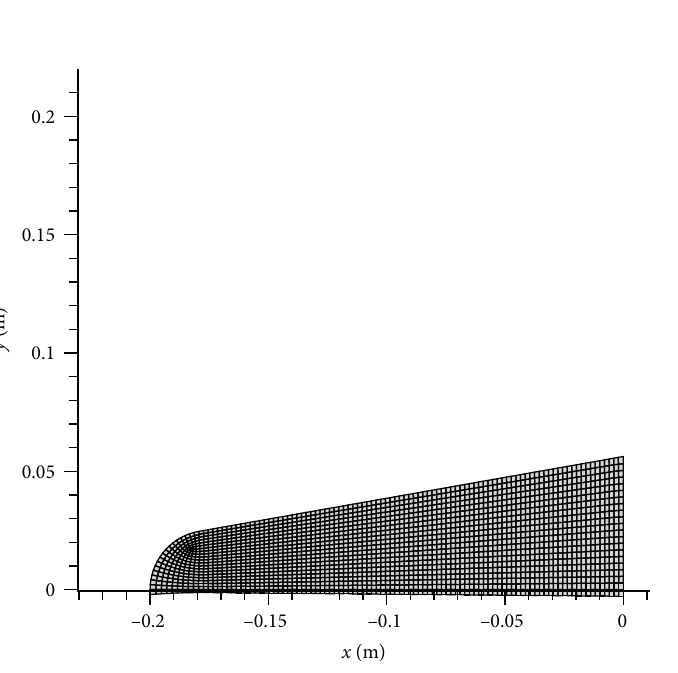
Figure 9: Grids of the fl ow fi eld.